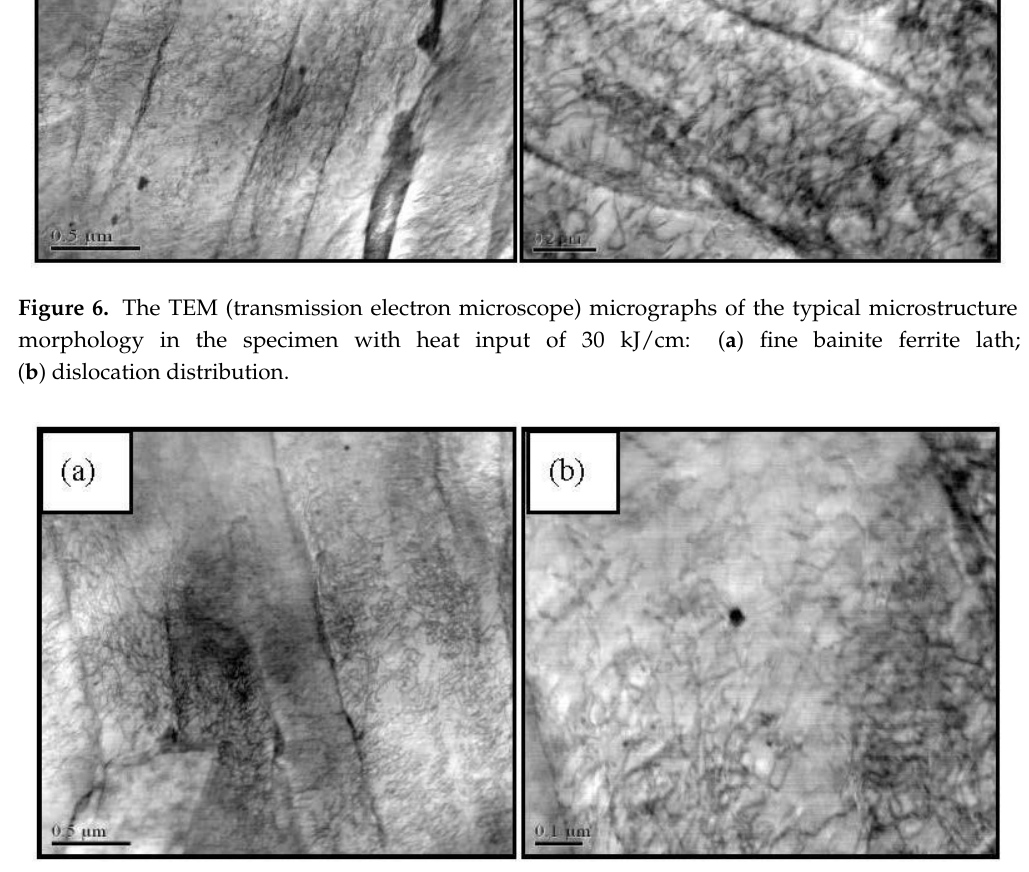
Figure 7. TEM micrographs of the typical microstructure morphology in the specimen with heat input of 60 kJ/cm: ( a ) broadening bainite ferrite lath; ( b ) dislocation distribution.